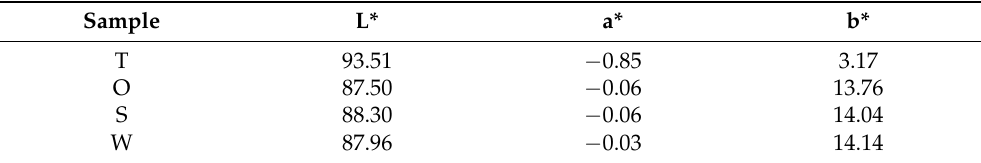
Table 2. Colorimetric coordinates of the four series of samples.